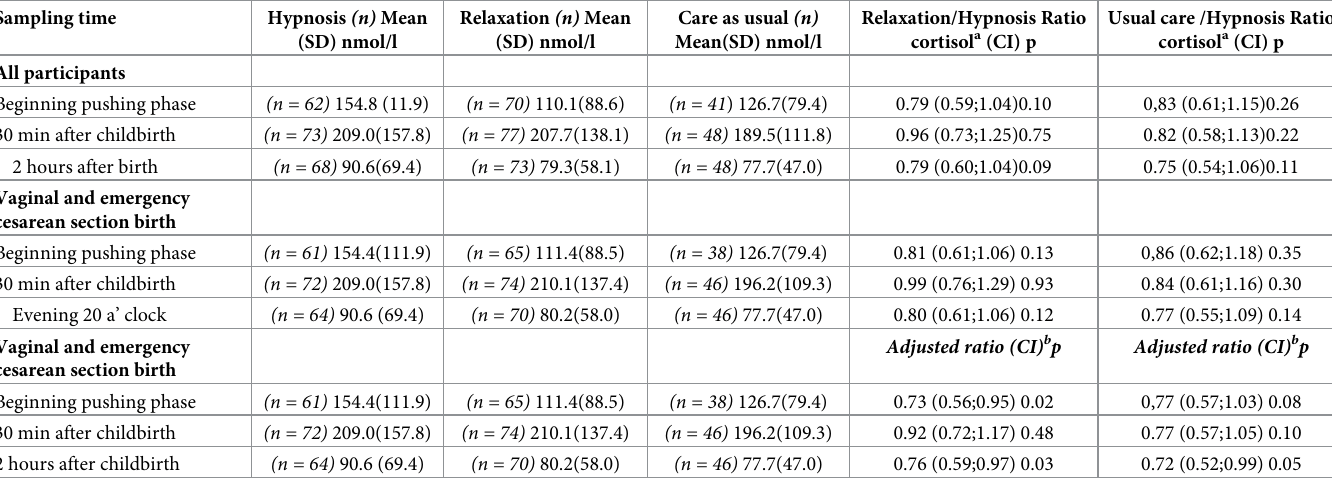
Table 3. Saliva cortisol concentration according to randomization group and between group differences during childbirth. Sampling